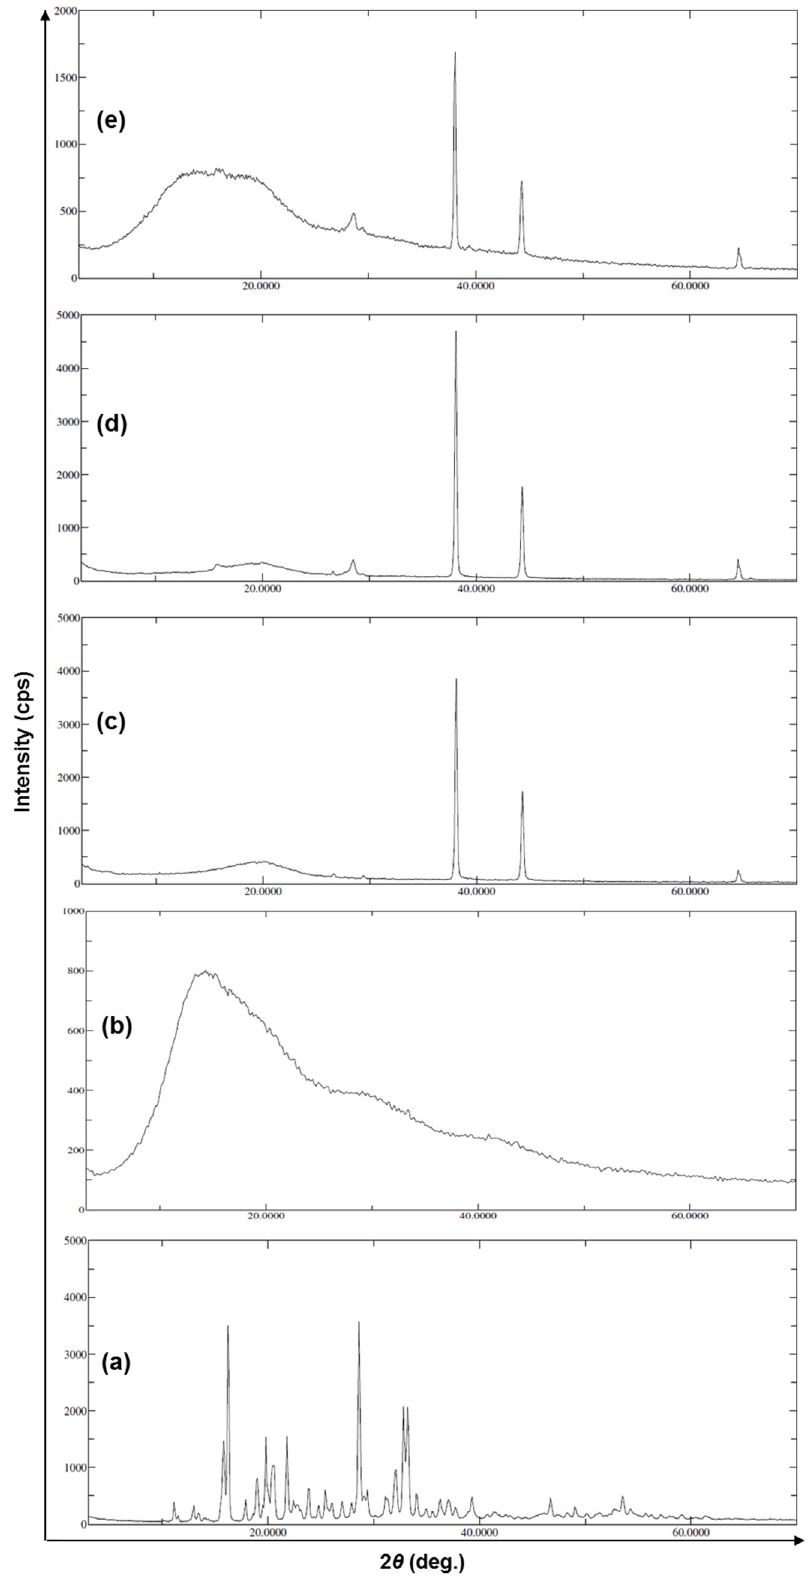
Figure 5. XRD patterns of pure drug 5-FU ( a ), Eudragit RS-100 (ERS) ( b ), SEMC alone ( c ), 5-FU-loaded SEMC (F2) ( d ), and 5-FU-loaded ERS-coated (F2-ERS) ( e ).